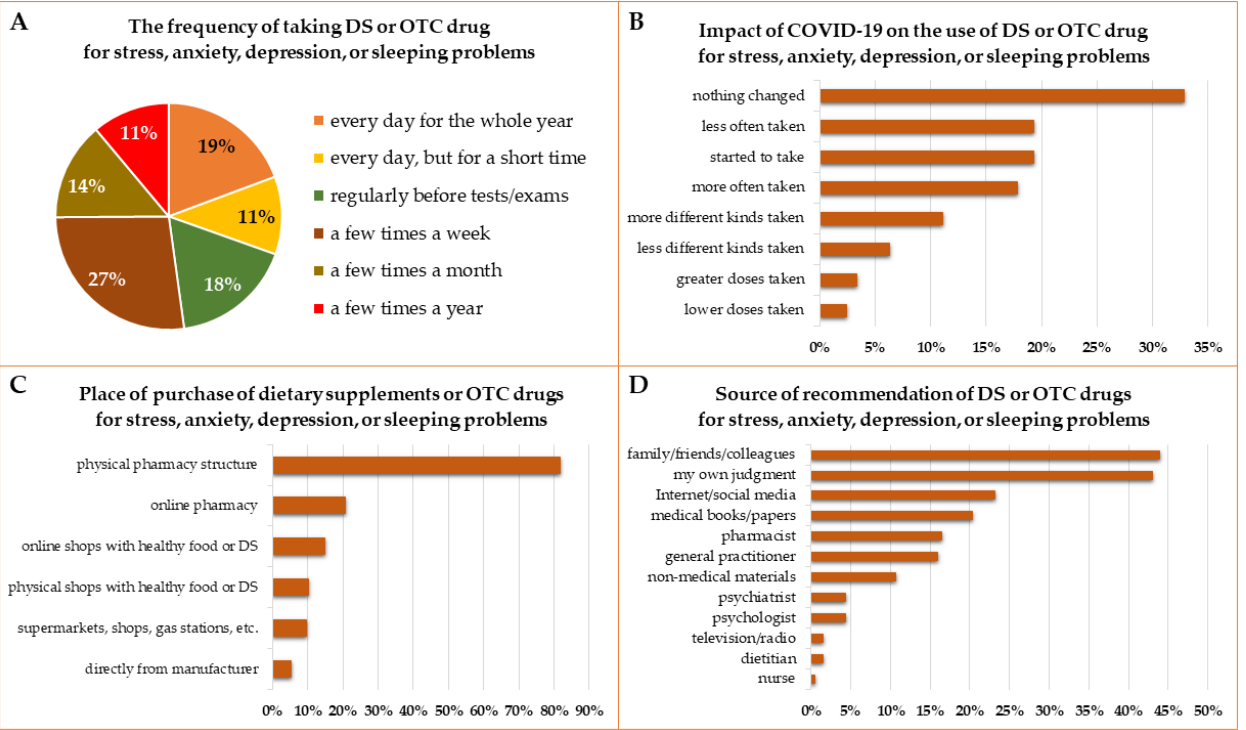
Figure 5. The frequency of taking DS and OTC drugs ( A ), the impact of the COVID-19 pandemic on the pattern of their use ( B ); place of purchase ( C ), and source of recommendation ( D ) of dietary supplements or OTC drugs for stress, anxiety, depression, or sleeping problems.